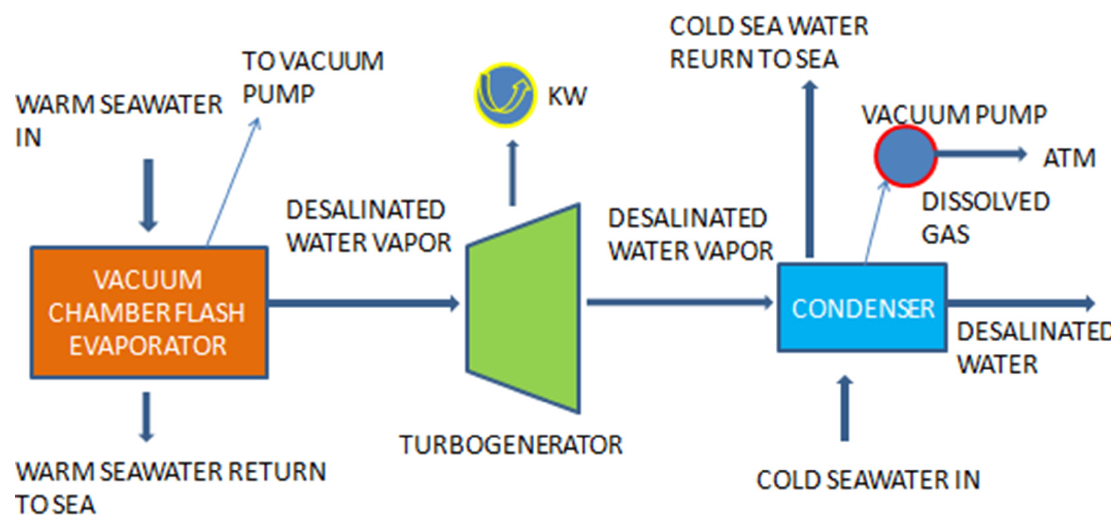
Figure 16. Conceptual diagram of an open-cycle OTEC. The parameters in the equation are power ( P ); the system’s overall efficiency ( η , 0.061 for an 85% efficient turbine); density ( ρ , 1000 kg/m 3 for seawater); specific heat of the seawater ( C p , 4.2 J/g · ◦ C); and temperature difference between hot and cool seawater ( ∆ T ) [133]. For example, a 255 kW open-cycle OTEC plant has a seawater flow rate